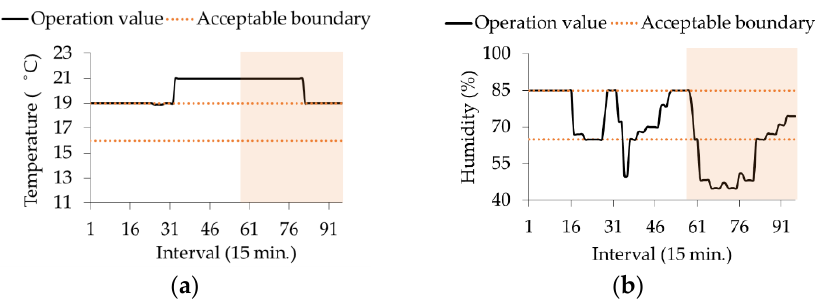
Figure 12. Environmental control of a building microgrid with rooftop greenhouse: ( a ) Temperature; ( b ) Humidity.